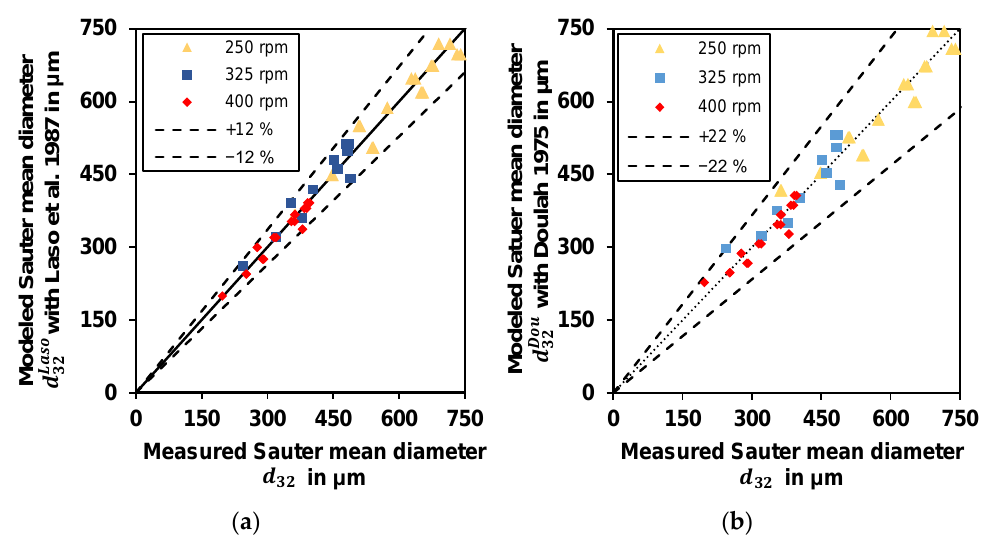
Figure 8. Parity plot: ( a ) model of Laso et al. [51] within 12% error, ( b ) model of Doulah [50] within 22% error (coefficients from Table 2).